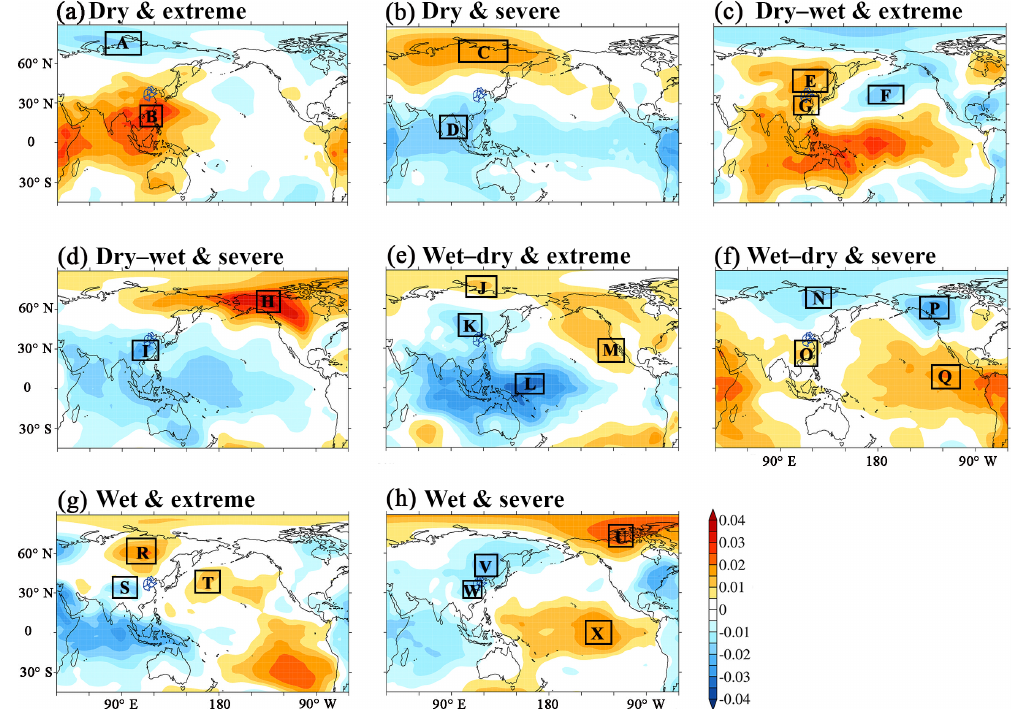
Figure 7. The first leading empirical orthogonal function (EOF) modes of standardized anomalies (SAs) for 500hPa geopotential height fields (HGT) during all severe and extreme drought process segments during different dry and wet spells in northern China, which is the region described with blue curves. The black boxes outline the selected areas used to structure predictors for northern China, while capital letters refer to the selected area